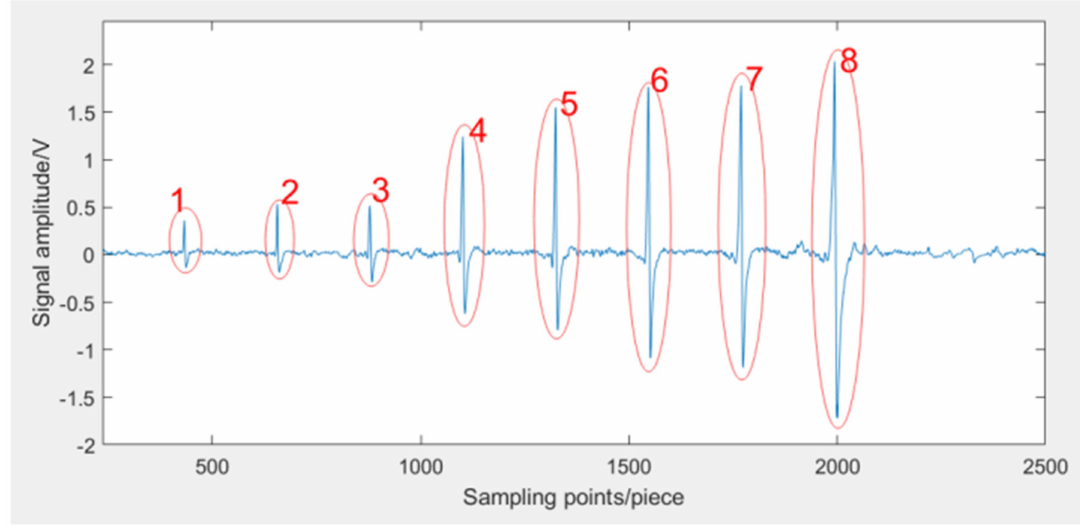
Figure 15. Filtered signal of the seventh sensor.